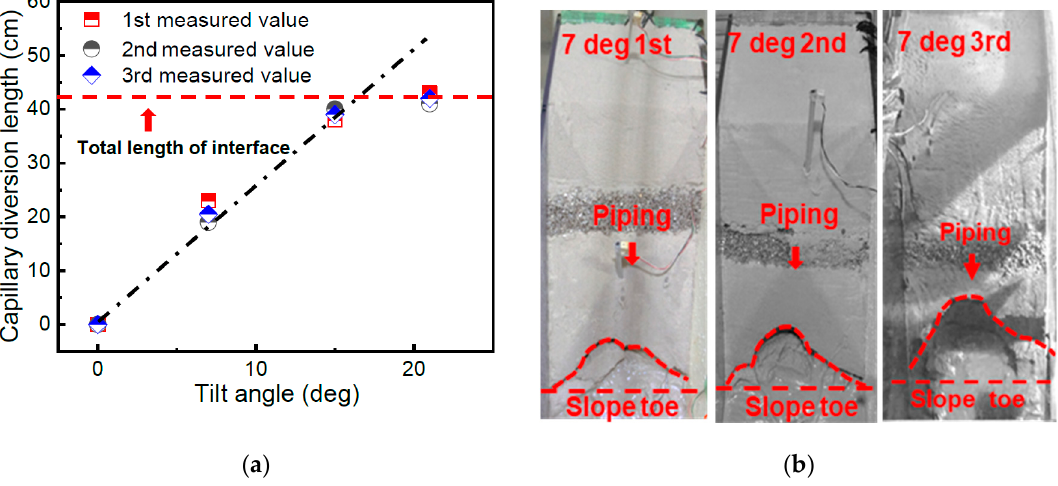
Figure 18. ( a ) Repeatability of the capillary diversion length (tilt angle α = 0°, 7°, 15°, and 21°, where each case was performed three times to ensure the repeatability of the results); ( b ) experiments of failure situations were conducted in case III under the same experimental conditions three times.